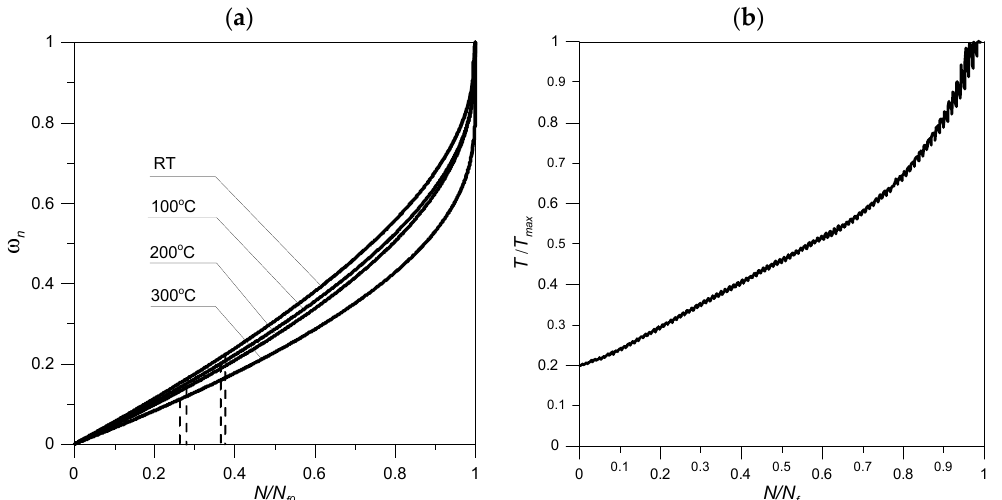
Figure 9. ( a ) Evolution of the damage state variable over the course of the action of fatigue load for different temperatures and strain levels ε a = 0.015. ( b ) Evolution of sample temperature over the course of cyclic loading at RT–Room Temperature.